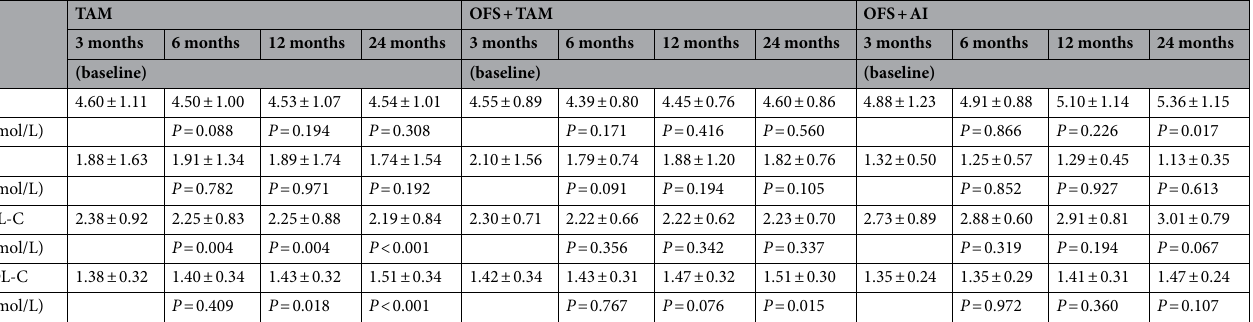
Table 2. Changes in lipid levels (mean and SD) from the third month to each time point among patients with different endocrine therapies. P value correspond to baseline (treated with endocrine therapy for 3 months).